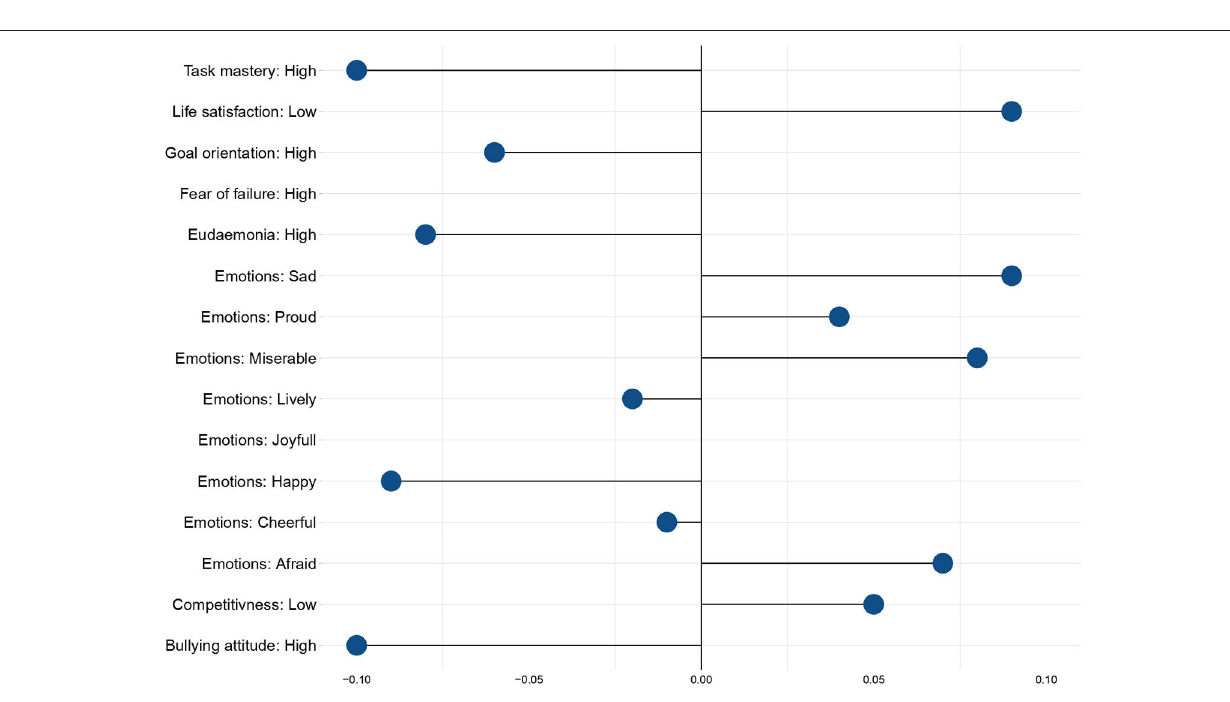
2019). The stigma associated with belonging to families with a lowest standing is exacerbated at school, and other classmates use it to highlight their dominance (Rean and Novikova, 2019;